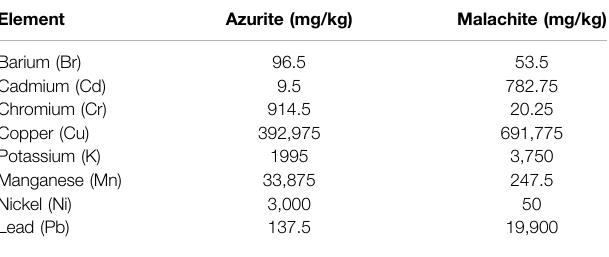
TABLE 2 | Heavy metal analysis for the collected azurite and malachite samples.